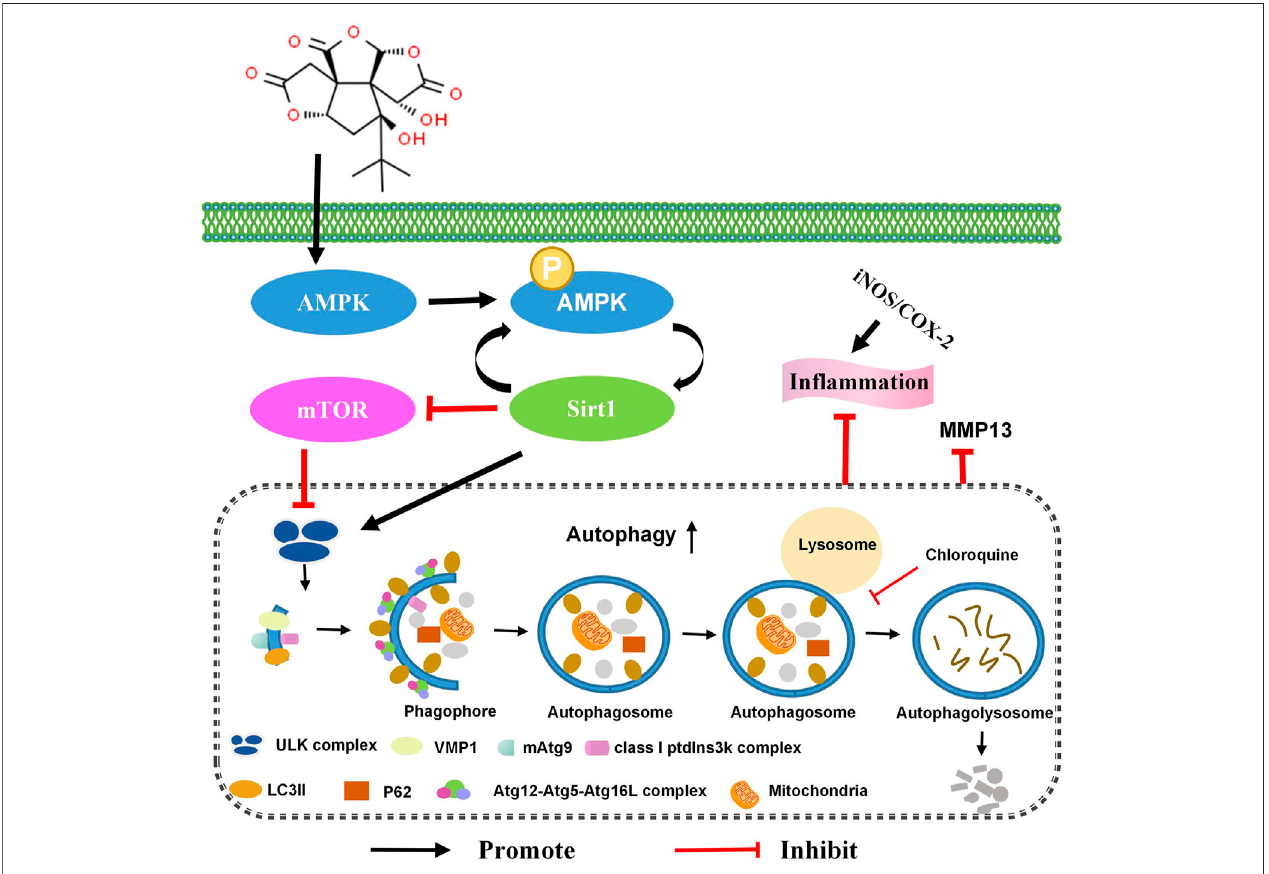
FIGURE7| BilobalidereducesIL-1 β -inducedATDC5chondrocytein fl ammationbyactivatingtheAMPK/SIRT/mTORpathway,leadingtochondrocyteautophagy.